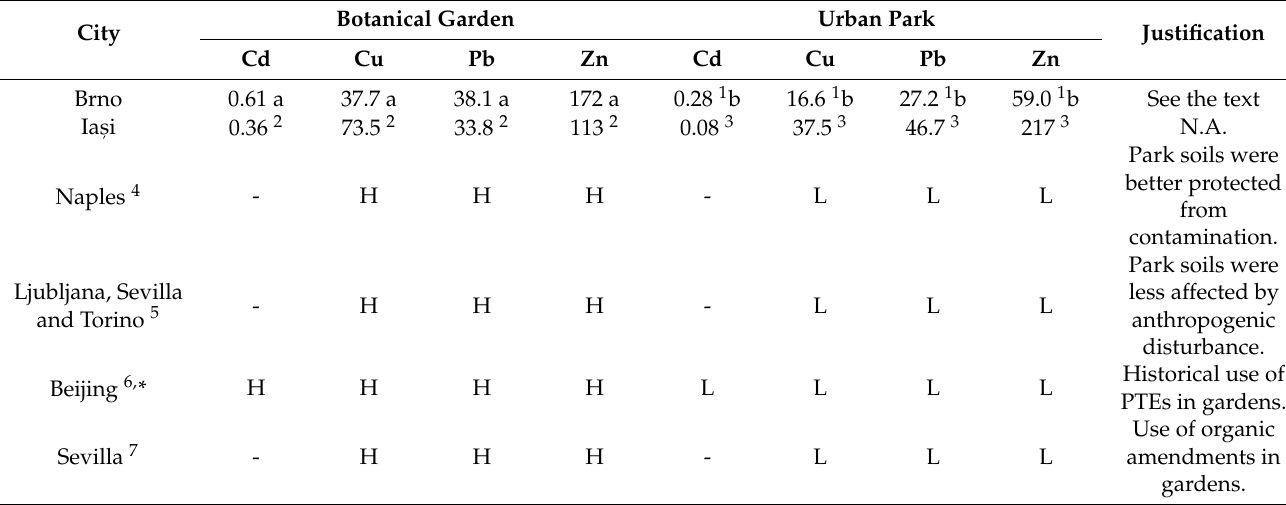
Table 3. Comparison of urban parks and botanical (or ornamental) gardens PTE contents (mg/kg). Lowercase letters indicate significant differences between their PTE contents at 0.05 (Tukey HSD test) when comparing urban gardens and urban parks in the PTE contents with non-available values: H = Higher content and L = Lower content. Botanical City